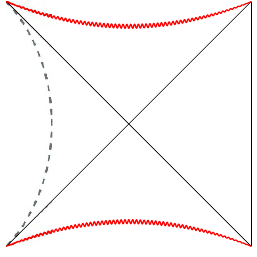
Figure 1 . A proposal for the geometry dual to a typical black hole